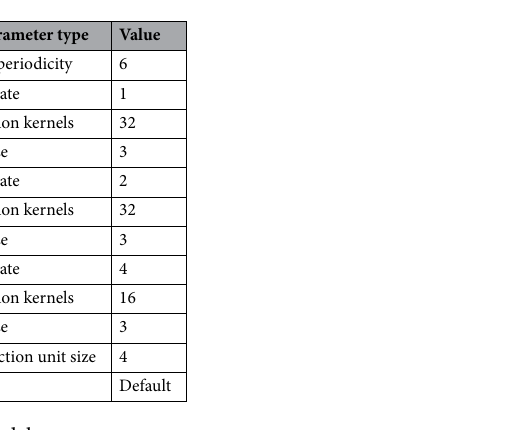
better the prediction effect of the model was. The calculation formula of RMSE is shown in Eq. (5).